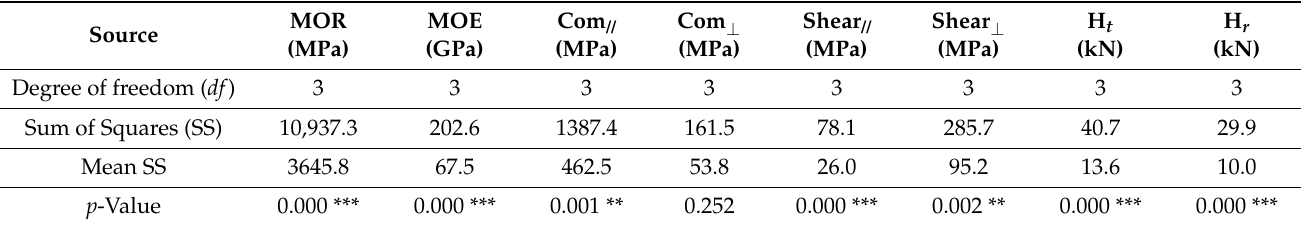
Table 5. Summary of ANOVA for the effect of infection by Crysoporthe deuterocubensis on the mechanical properties of Eucalyptus urograndis lumbers.